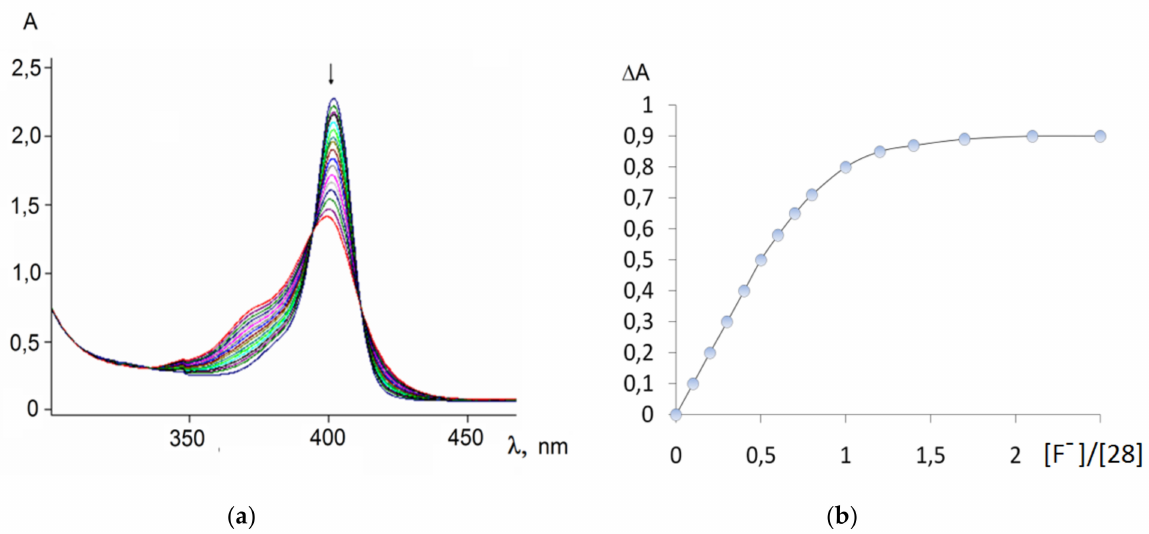
Figure 8. Changes in the absorption spectra ( a ) and the titration curve ( b ) of receptor 63 with a fluoride ion [ 28 ] = 4.5 × 10 − 6 M, [F − ] = 0 ÷ 1,2 × 10 − 5 M in CD 2 Cl 2 , 298 K [67].